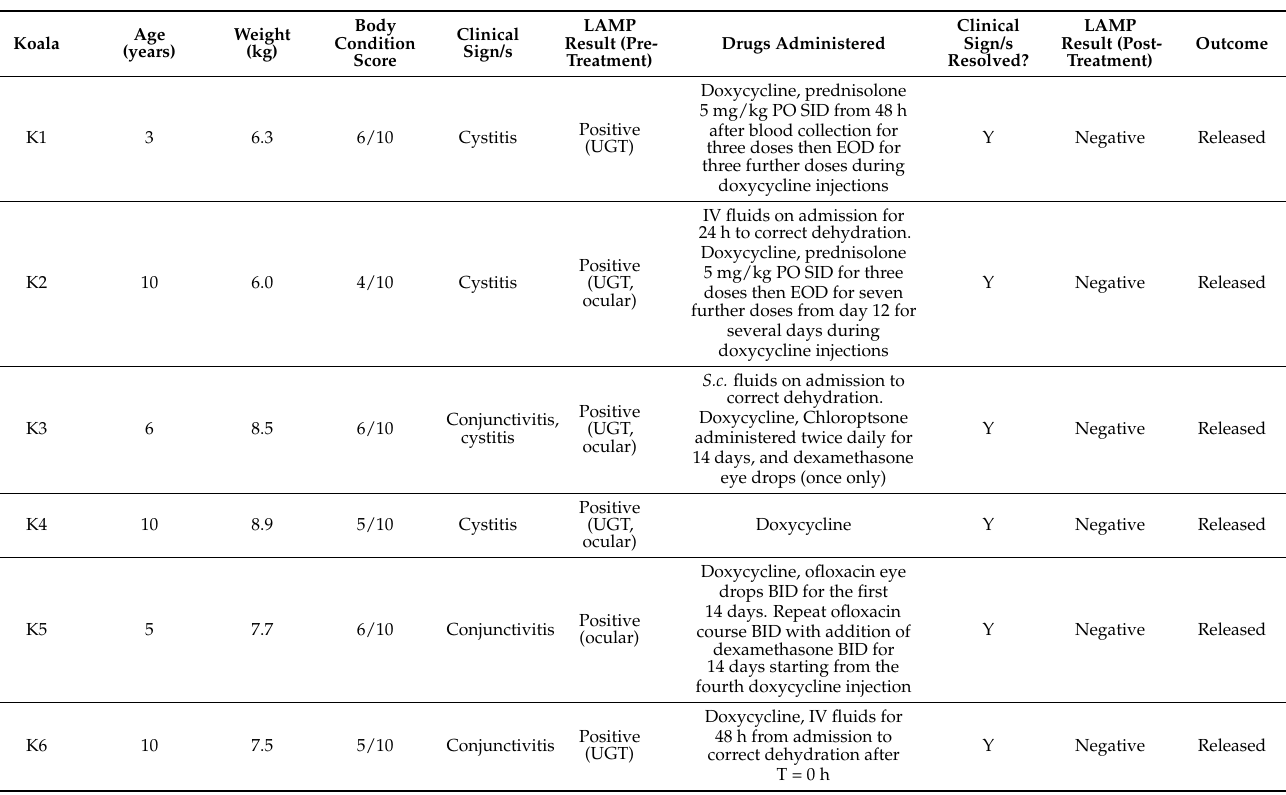
Table 1. Demographic information of the six male koalas recruited and their axillary drug treatments during the administration of doxycycline 5 mg/kg by subcutaneous injection (diluted 50:50 with saline), once a week for four